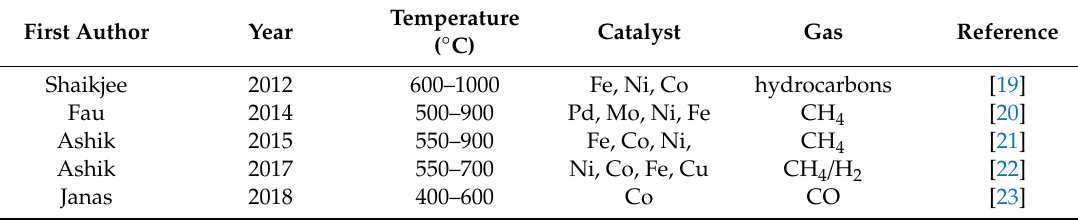
Table 1. Recent review articles of carbon formation above 550 ◦ C.